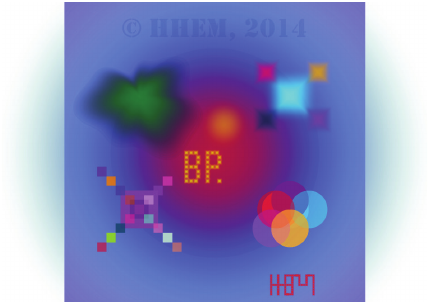
Figure 10: Brain Painting entitled “Die EU Muskeltiere, the EU Muscleteers,” with kind permission from the artist.